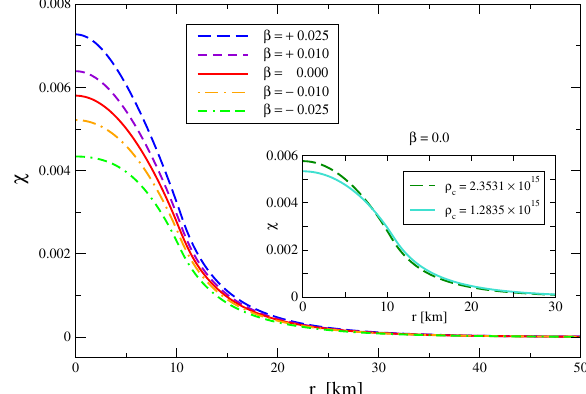
Fig. 2 Radial profile of scalar curvature R ( r ) for different values of β ( β = 4 B ω ) with central density ρ c = 2 . 5414 × 10 15 g cm − 3 . The inset shows the scalar curvature profile for the Starobinsky model ( β = 0) with two different central densities ρ c (in g cm − 3 )